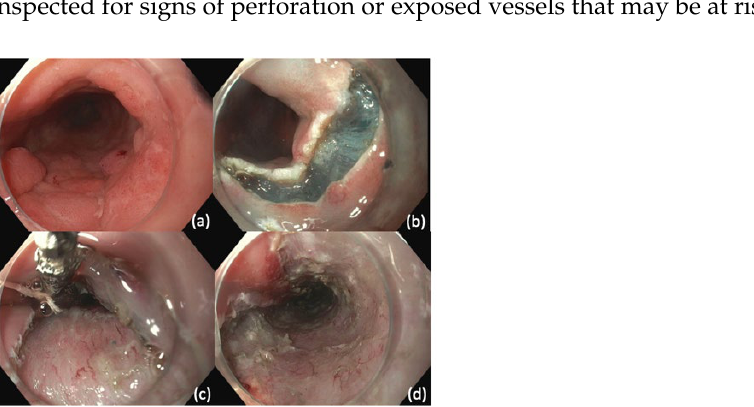
Figure 2. Endoscopic Submucosal Dissection (ESD). ( a ) Nodular mass lesion representing focally invasive adenocarcinoma ( b ) Distal mucosa incision performed after submucosal injection ( c ) Tunnel creation by ESD ( d ) Defect after completion of en bloc resection.